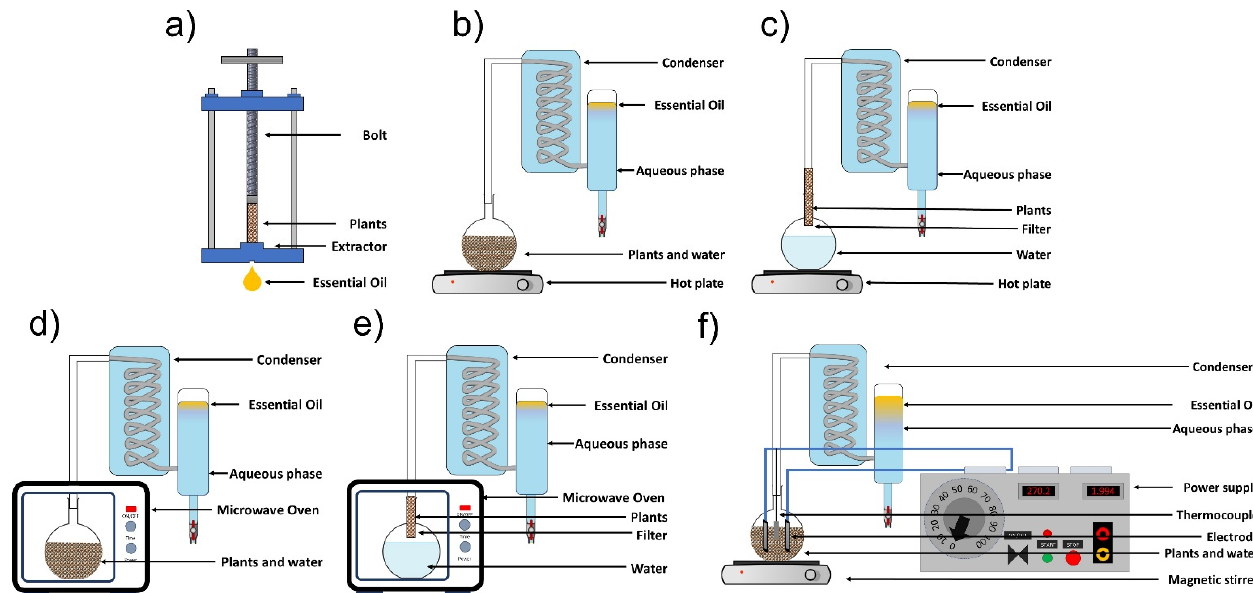
Figure 2. Essential oil extraction methods: ( a ) cold pressing, ( b ) hydrodistillation, ( c ) steam distillation, ( d ) microwave- assisted hydrodistillation, ( e ) microwave-assisted steam hydrodistillation, and ( f ) ohmic heating-assisted hydrodistillation (adapted from Golmakani [19] and Hatami et al. [20]).